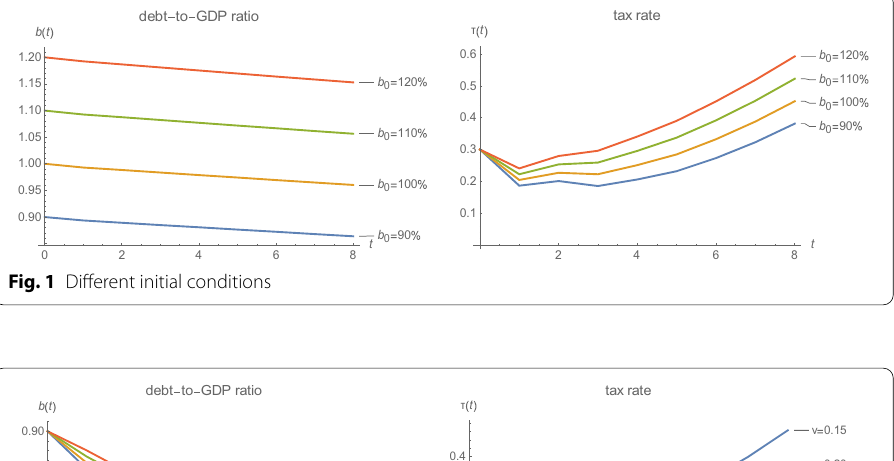
Fig. 1 Different initial conditions